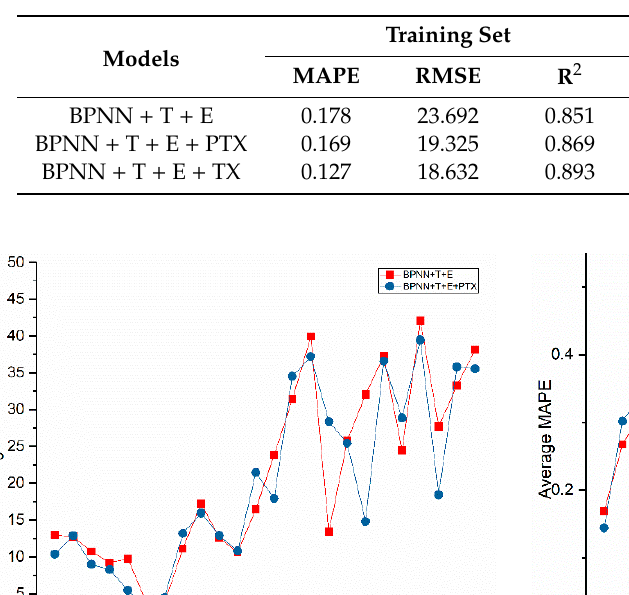
Figure 10. The demand prediction of online taxi-hailing based on the model “BPNN + T + E + PTX”. Table 10. Prediction e ff ects of model “BPNN + T + E”, “BPNN + T + E + PTX” and “BPNN + T + E + TX”.